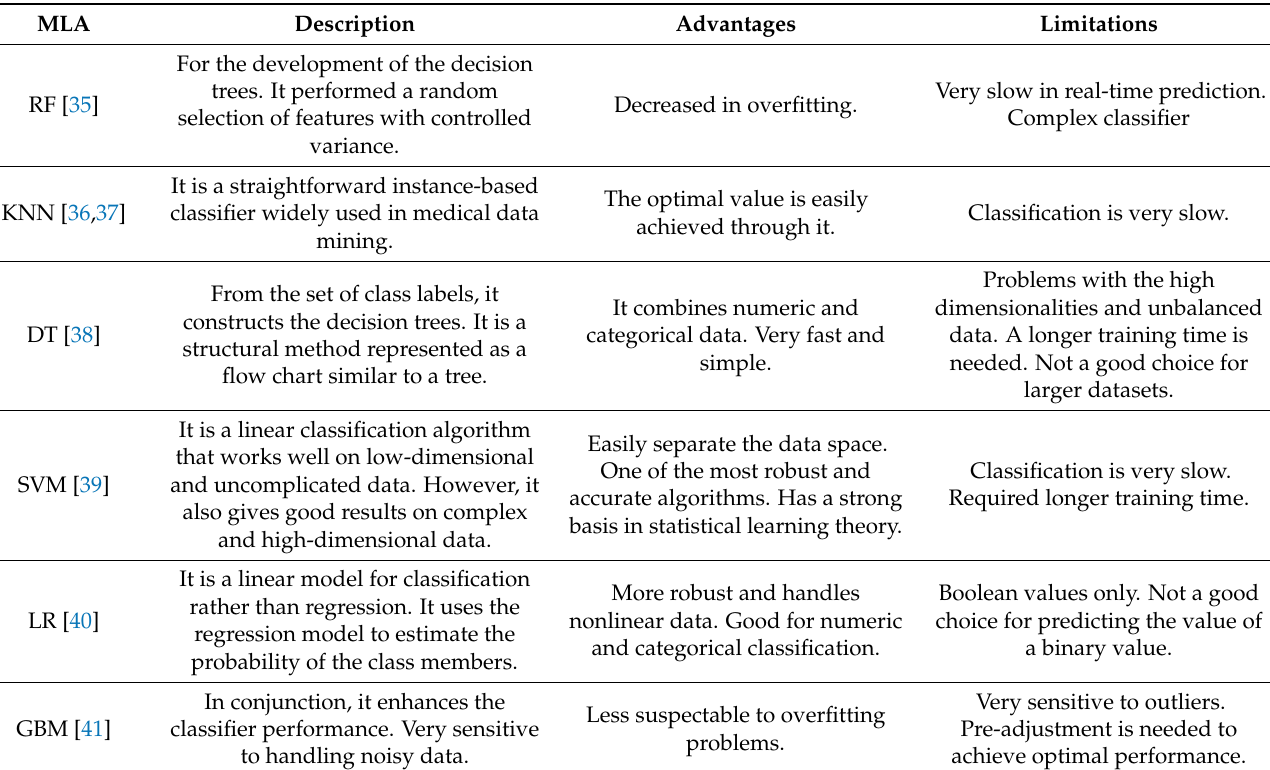
Table 3. Brief description of machine learning